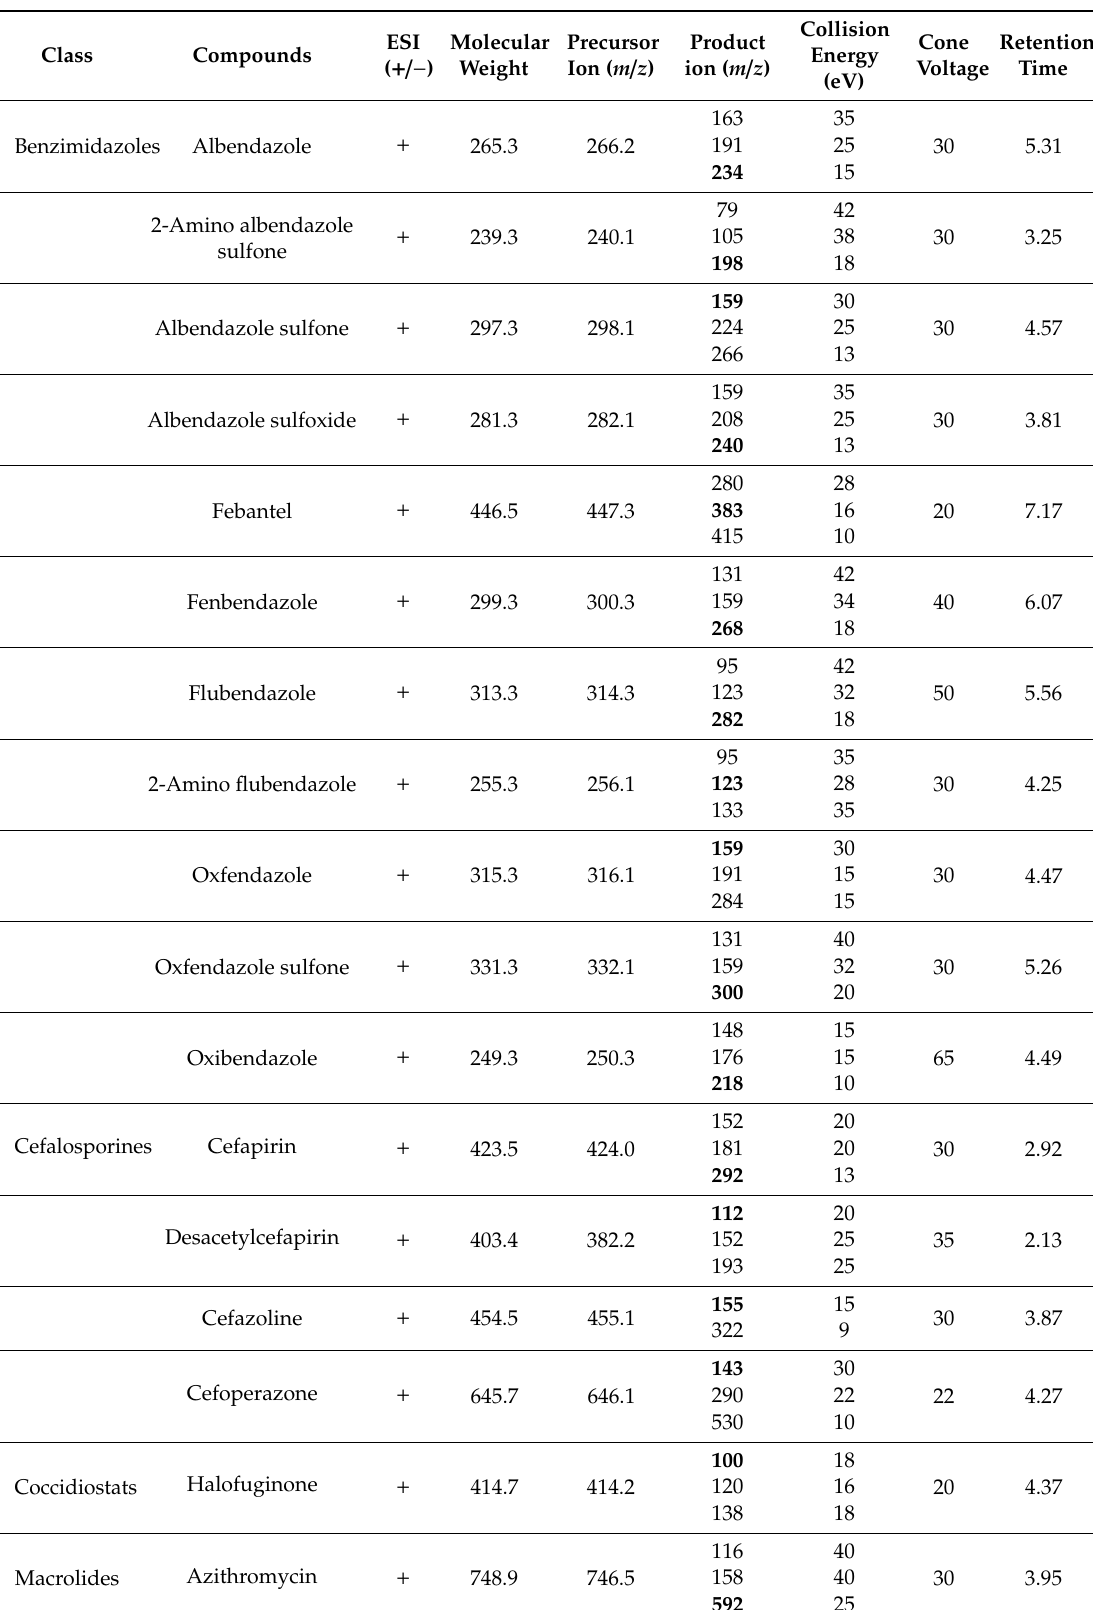
Table 1. LC-MS / MS parameters of target veterinary